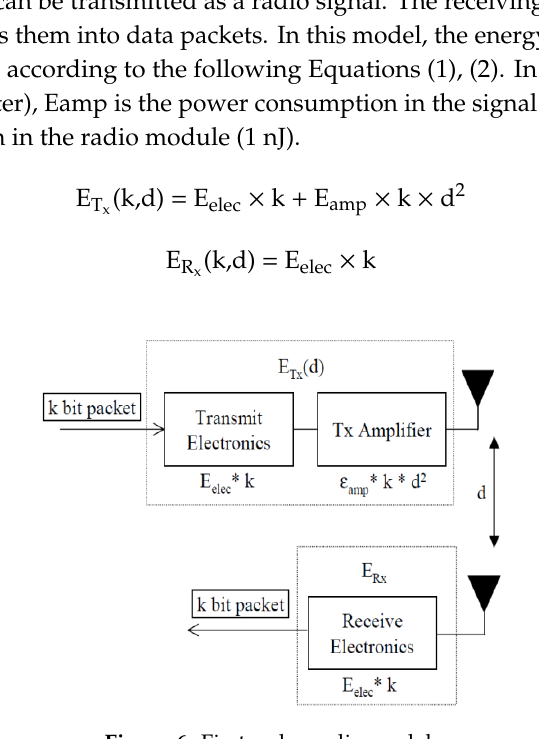
Figure 6. First order radio model.